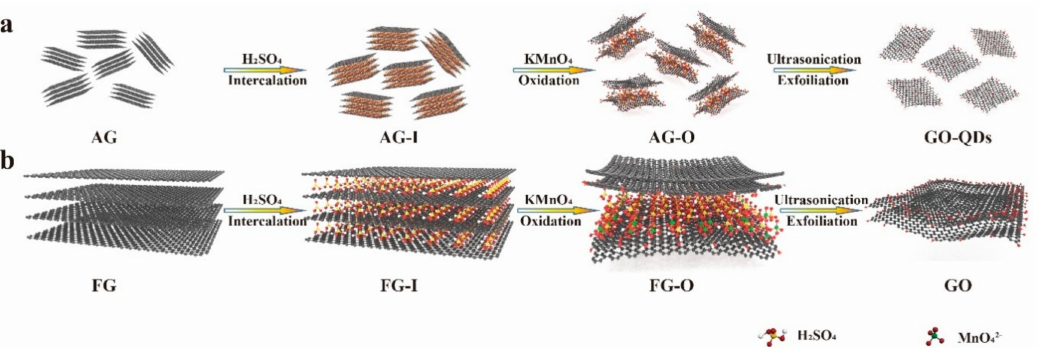
Figure 5. Schematic of the exfoliating of ( a ) AG and ( b ) FG with the same amount of intercalator and